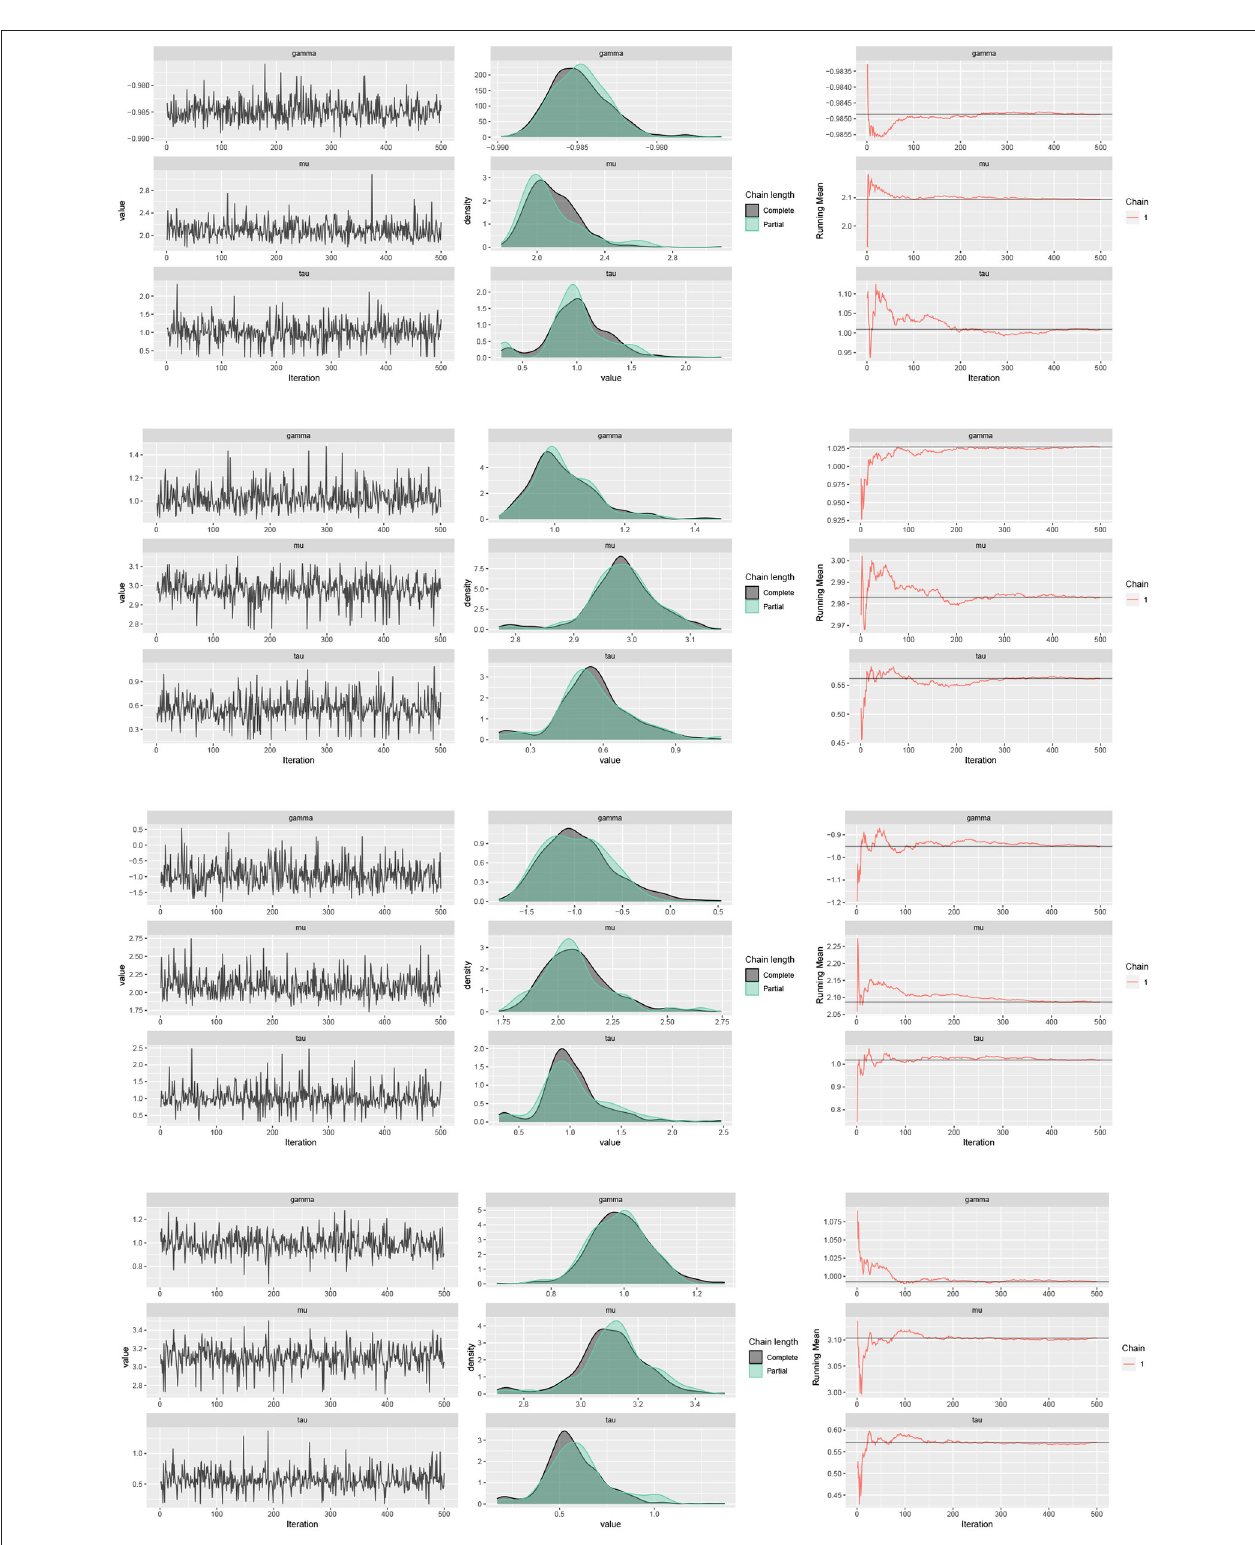
FIGURE 2 | Traceplots, mean running and estimated posterior pdf plots of generated samples for ( µ , τ , γ ) in Table 1 for p scenario 2 (second row), scenario 3 (third row), and scenario 4 (fourth row).